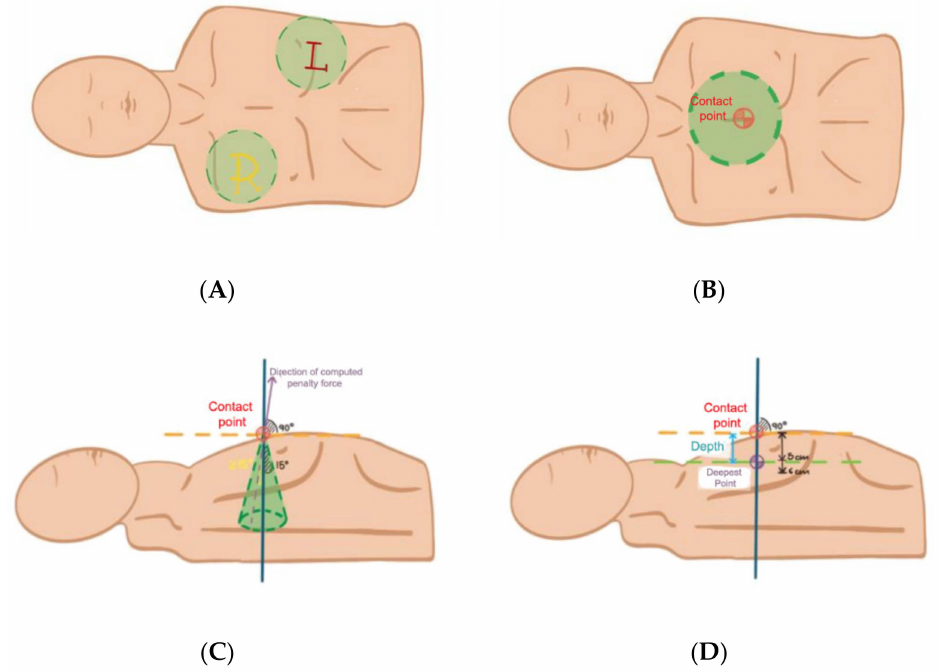
Figure 7. ( A ) Yellow R represents the right electrode location, Red L represents the left electrode location. ( B ) indicates the correct contact point. ( C , D ) indicate the direction and deepest point of RCP